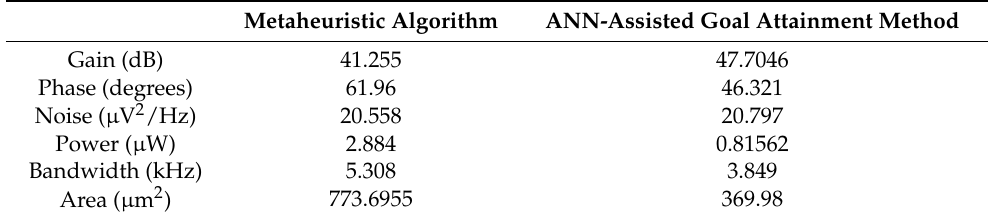
Table 8. Metaheuristic algorithm results vs. ANN-assisted goal attainment